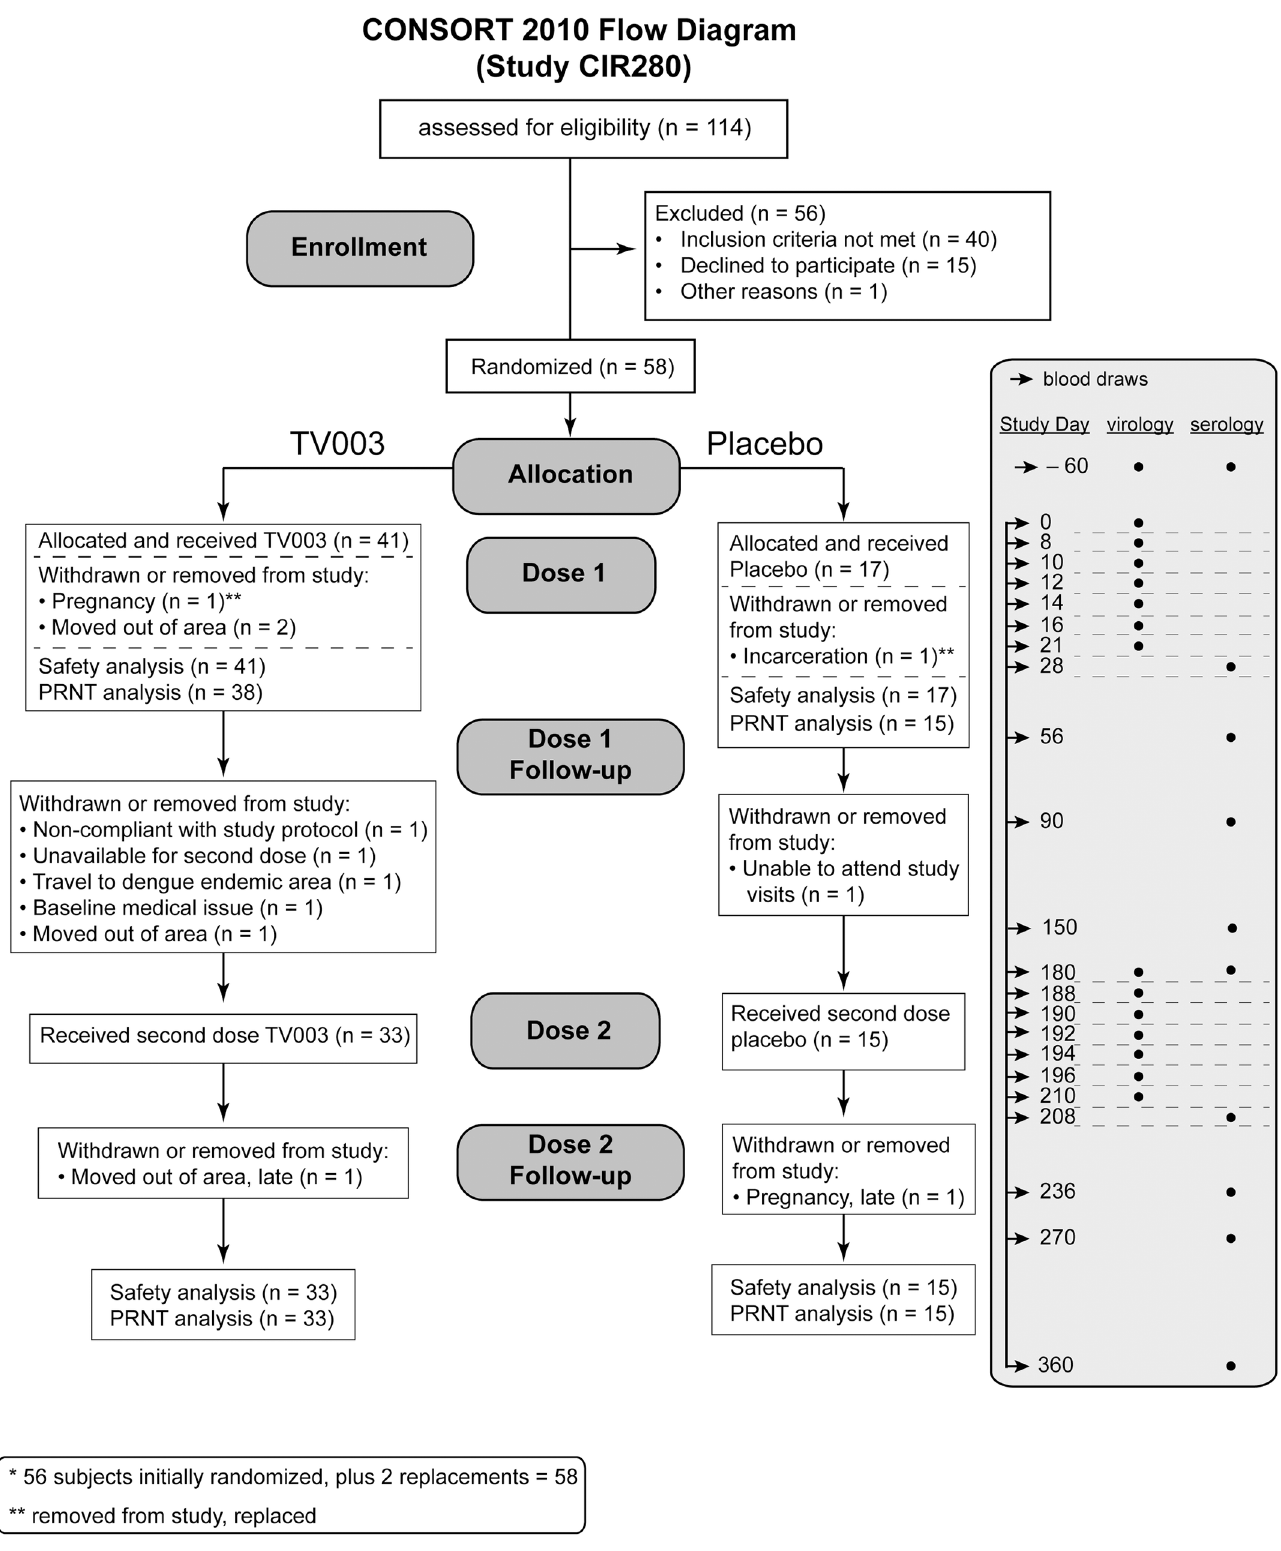
Fig 1. CONSORT diagram of enrollment and follow up of subjects for first and second dosings of TV003 in subjects who were flavivirus- exposed prior to vaccination with TV003 (Study CIR280). The scheduleof blood draws for serological and virologicaltesting is indicatedin the shaded box at